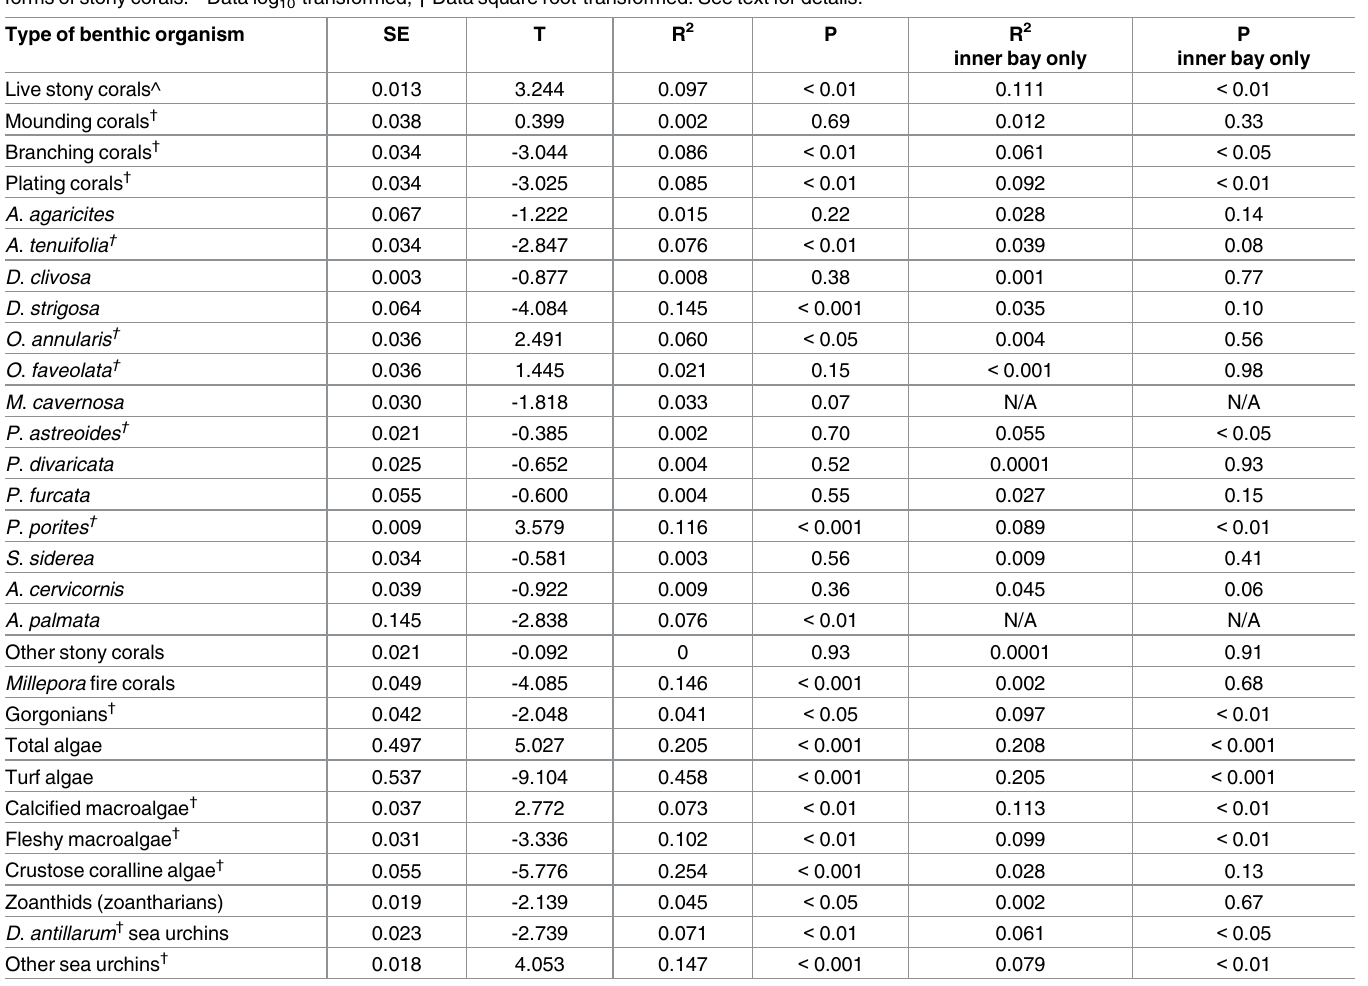
Table 2. Results of ordinary least squares regression (OLS) analysis of variation in the percent cover of benthic organisms among patch reefs ranked by level of snorkeling in Akumal Bay, Mexico. All categoriesof organisms were quantified as percent cover except for sea urchins, which were assessedas abundance of individuals. Seagrasses(phanerogams) did not occur on the patch reefs and were not includedin the present table. Columns includevalues for all 10 patch reefs examinedin the bay, except for the last 2 columnswhich show values for only the 8 inner bay patch reefs, excludingthe 2 outer bay patch reefs (see map Fig 1B for reef locations). The percent cover of both M . cavernosa and A . palmata was too low to be analyzedstatistically for variationamongonly the 8 inner bay sites. Mounding,branching,and plating corals were definedas all species belongingto each of these 3 major growth forms of stony corals. ^ Data log 10 -transformed, † Data square root-transformed. See text for